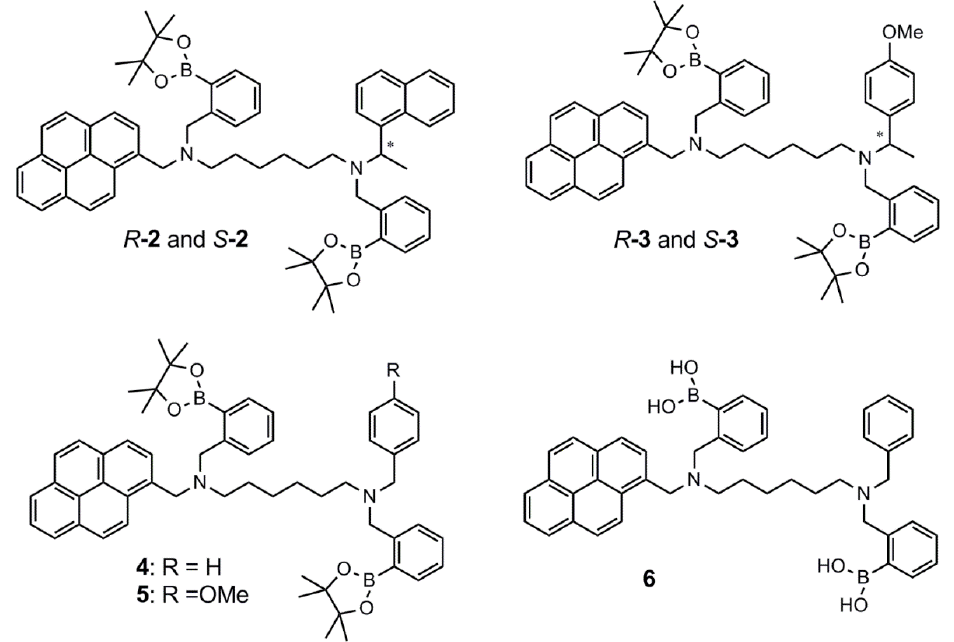
Figure 2. The aryl diboronic acid sensors, 2 – 6 , synthesized and tested by James and co-workers